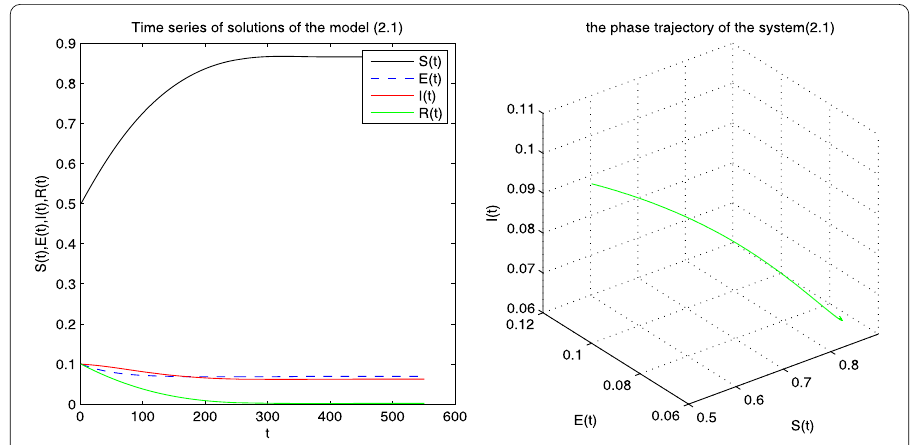
Figure 2 The endemic equilibrium E c of system (2.1) is globally asymptotically stable.